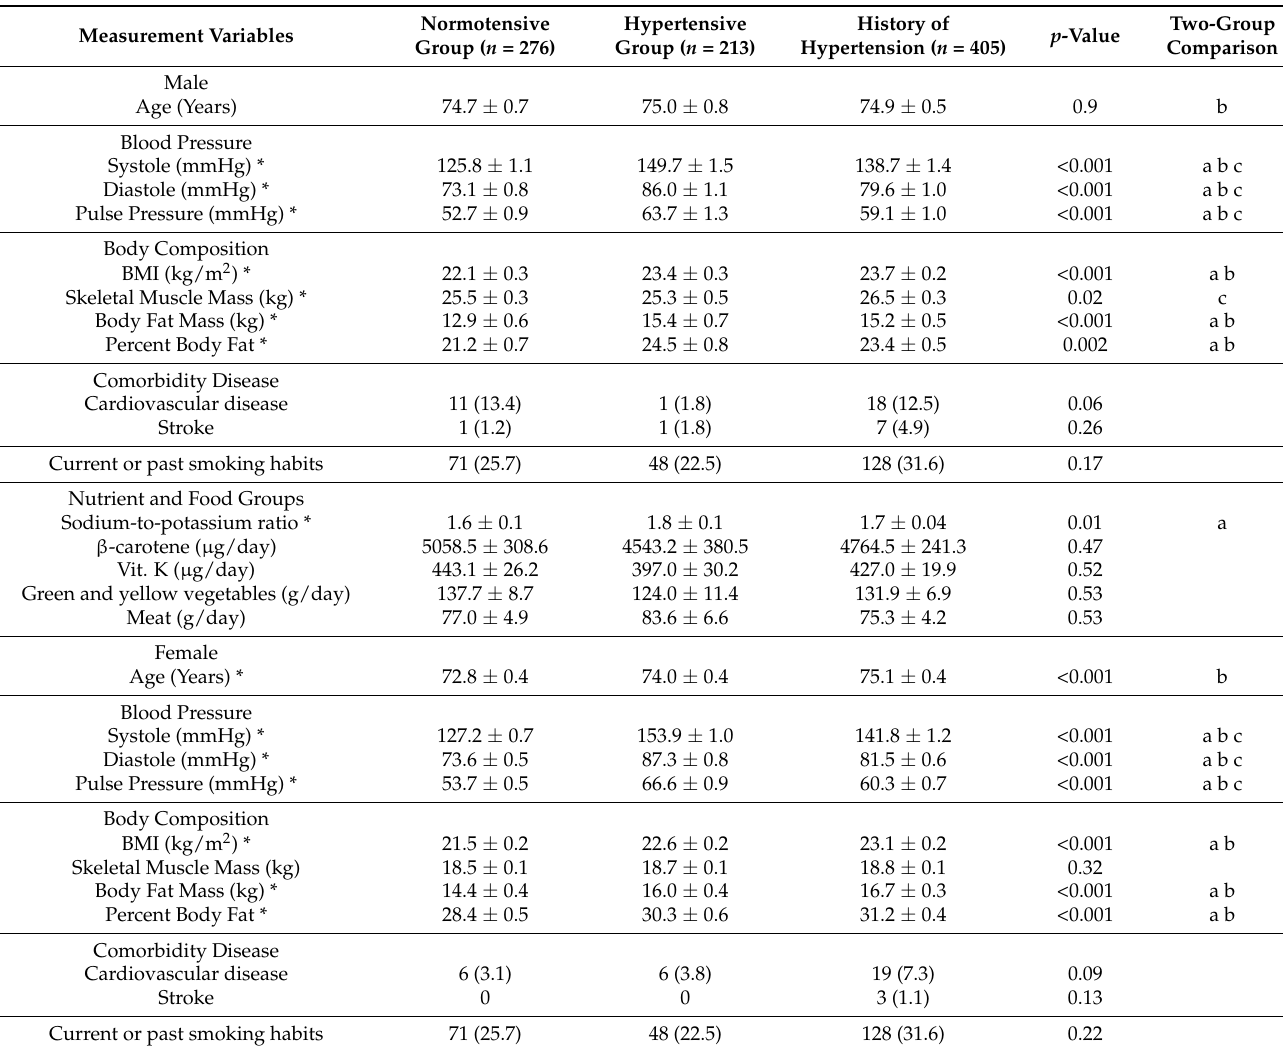
Table A3. Comparison of nutrient and dietary intake among groups by